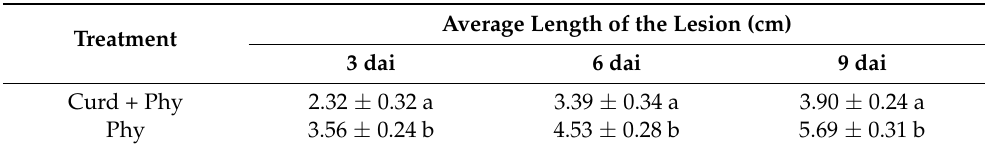
Table 1. Lesion length caused by P. cinnamomi on avocado plants sprayed with curdlan and on untreated plants inoculated with the pathogen.